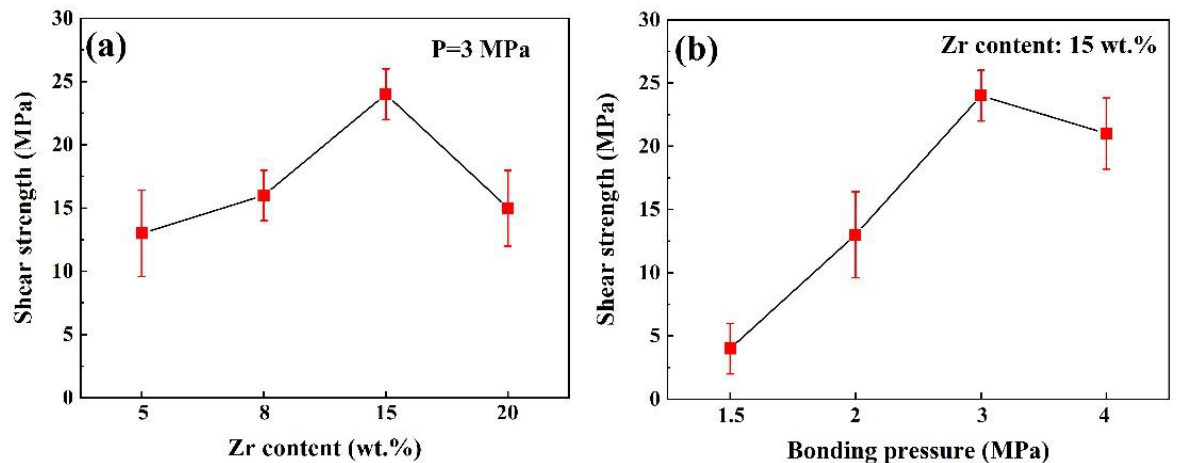
Figure 12. Influence of the ( a ) interlayer composition and ( b ) bonding pressure on the joint shear strength.